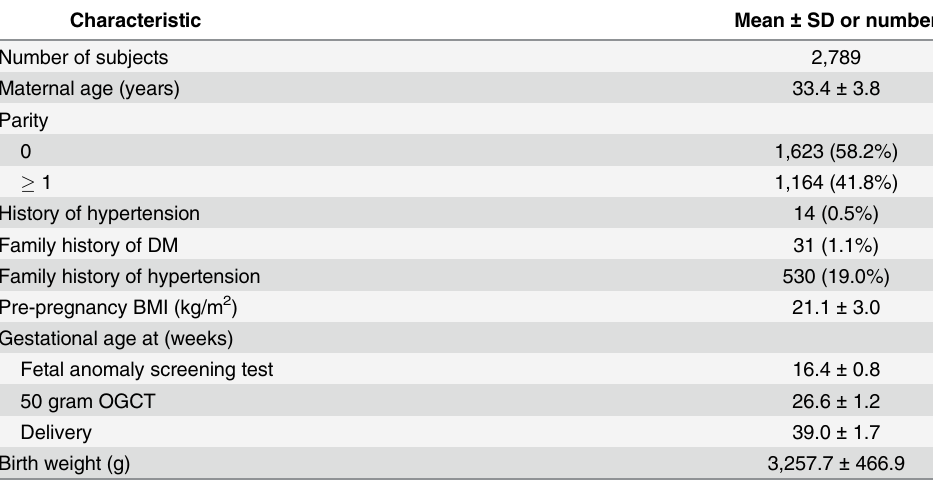
Table 1. Clinical characteristics of study